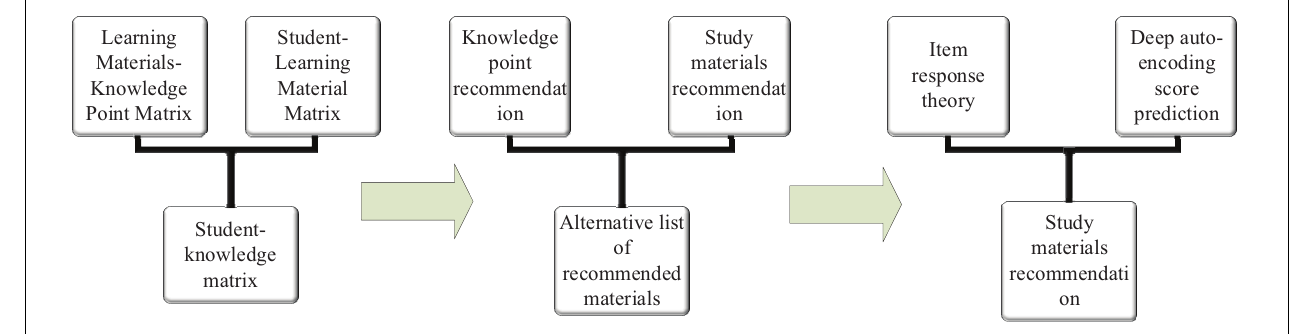
FIGURE 2 | Personalized learning material recommendation algorithm.